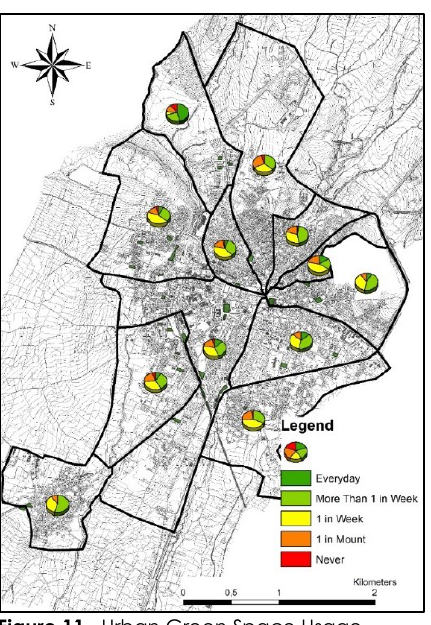
Figure 11. Urban Green Space Usage.